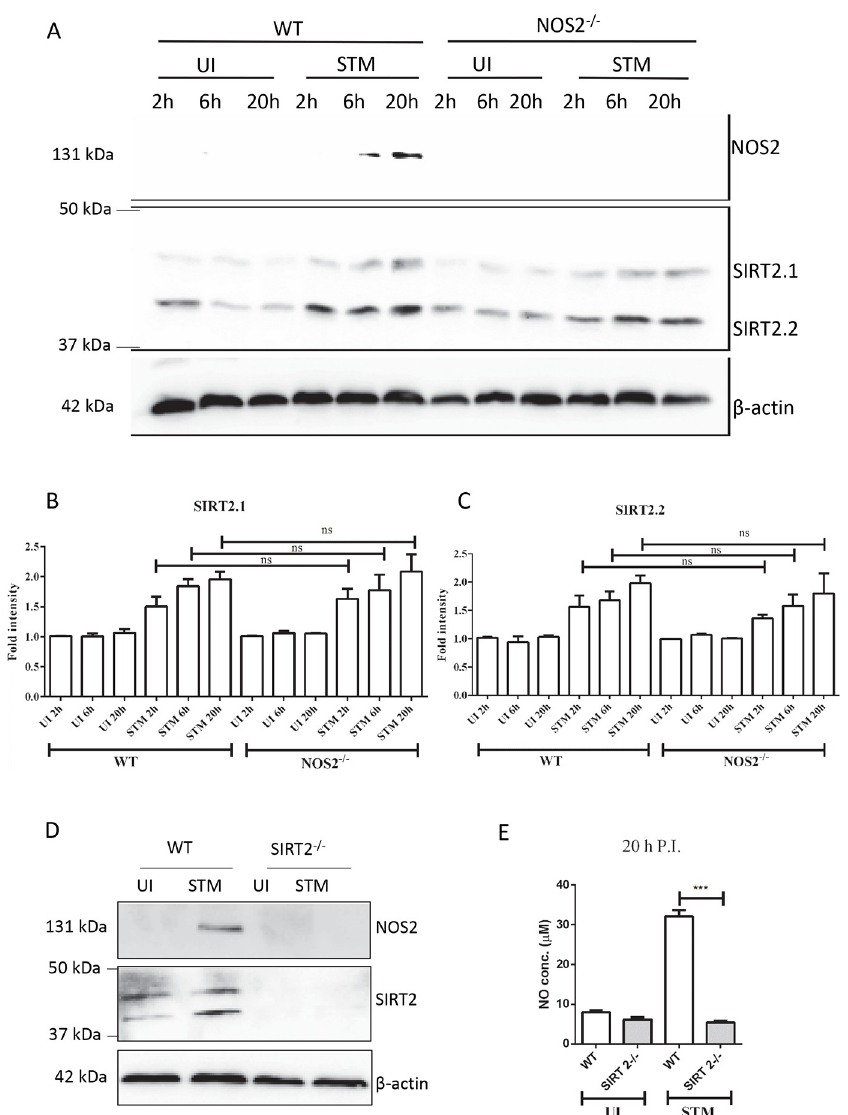
Fig 4. SIRT2 is upstream of NOS2. A. Representative immunoblot of NOS2 and SIRT2 in wild type and NOS2 -/- DCs at the indicated time point. (UI- uninfected, STM- Salmonella Typhimurium infected) B. Densitometry analysis of SIRT2.1 in wild type and NOS2 -/- DCs at the indicated time point. (UI- uninfected, STM- Salmonella Typhimurium infected). (Data are presented as mean ± SEM of 2 independent experiments) C. Densitometry analysis of SIRT2.2 in wild type and NOS2 -/- DCs at the indicated time point. (UI- uninfected, STM- Salmonella Typhimurium infected). (Data are presented as mean ± SEM of 2 independent experiments) D. Representative immunoblot of NOS2 and SIRT2 in wild type and SIRT2 -/- DCs at the indicated time point. (UI- uninfected, STM- Salmonella Typhimurium infected) E. Nitric oxide levels in conditioned media in response to Salmonella infection at 20 h post infection. (UI- uninfected DCs, STM- Salmonella Typhimurium infected DCs) (Data are presented as mean ± SEM of 3 independent experiments). (unpaired two-tailed Student’s t-test, p-value, ��� < 0.0001, �� < 0.001, � < 0.01).